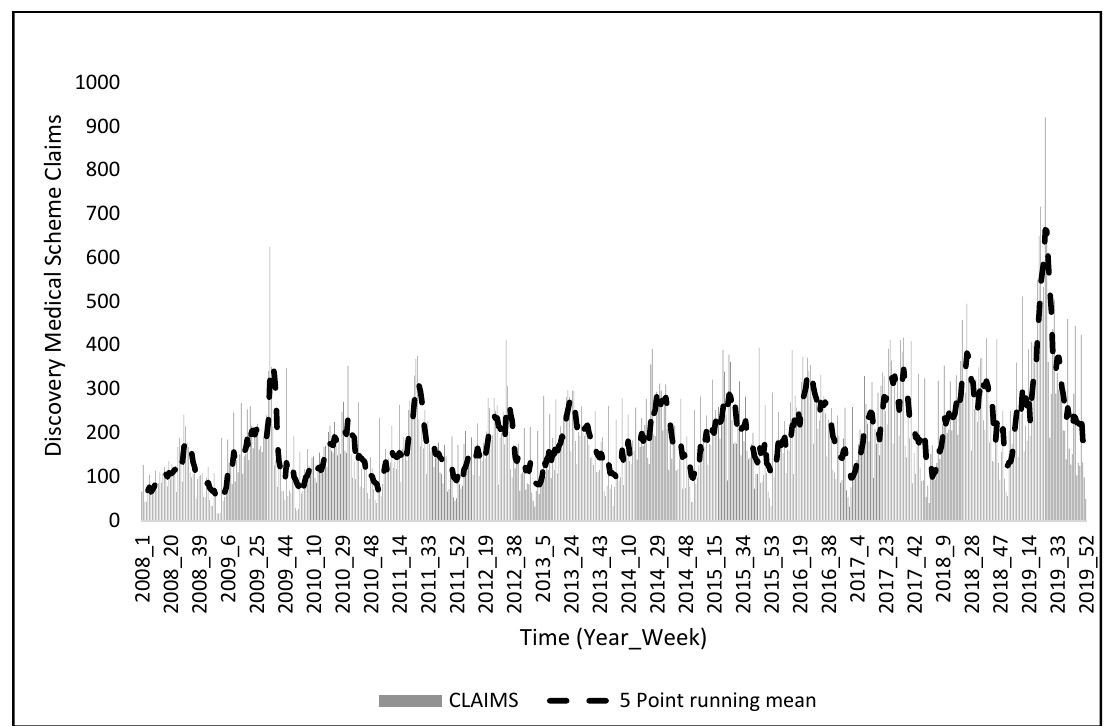
Figure 3. Weekly medical insurance claims for South Africa and the 5-point running mean (2008–2019).